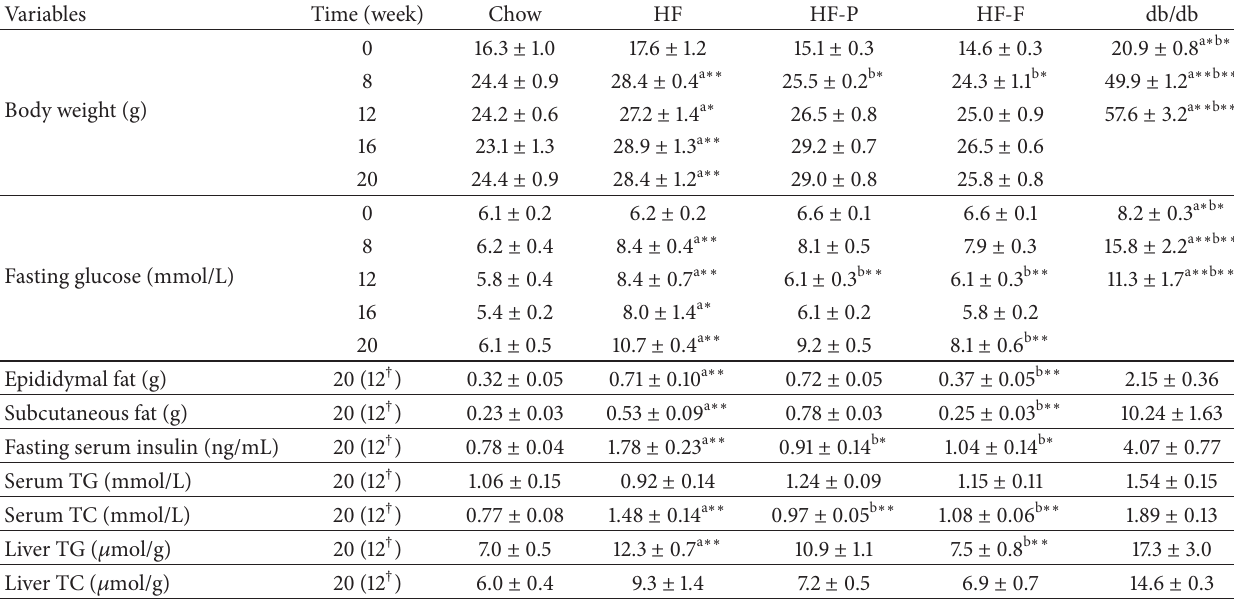
Table 1: Metabolic phenotypes in mice before and after